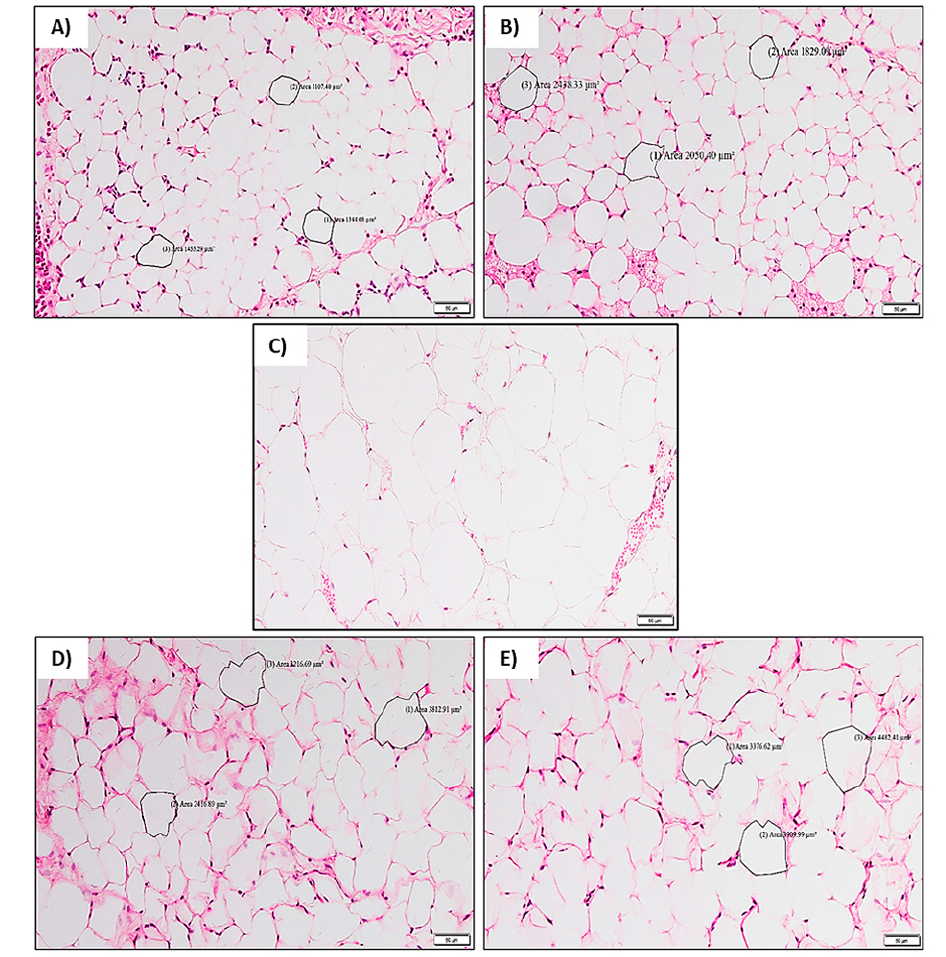
Figure 5. The histomorphometry of the adipocyte tissue of all groups. The size of the adipocytes was increased in the FDW group ( C ) compared to the baseline ( A ) and control ( B ) groups. The size of adipocytes of FDW-PS ( D ) and FDW-NGN ( E ) were reduced compared to FDW. The size of the adipocytes was measured and indicated using surface area (µm 2 ). Scale bar represents 60 µm. FDW: Olive oil + 20% fructose; FDW-PS: PS + 20% fructose; FDW-NGN: Naringin + 20% fructose.